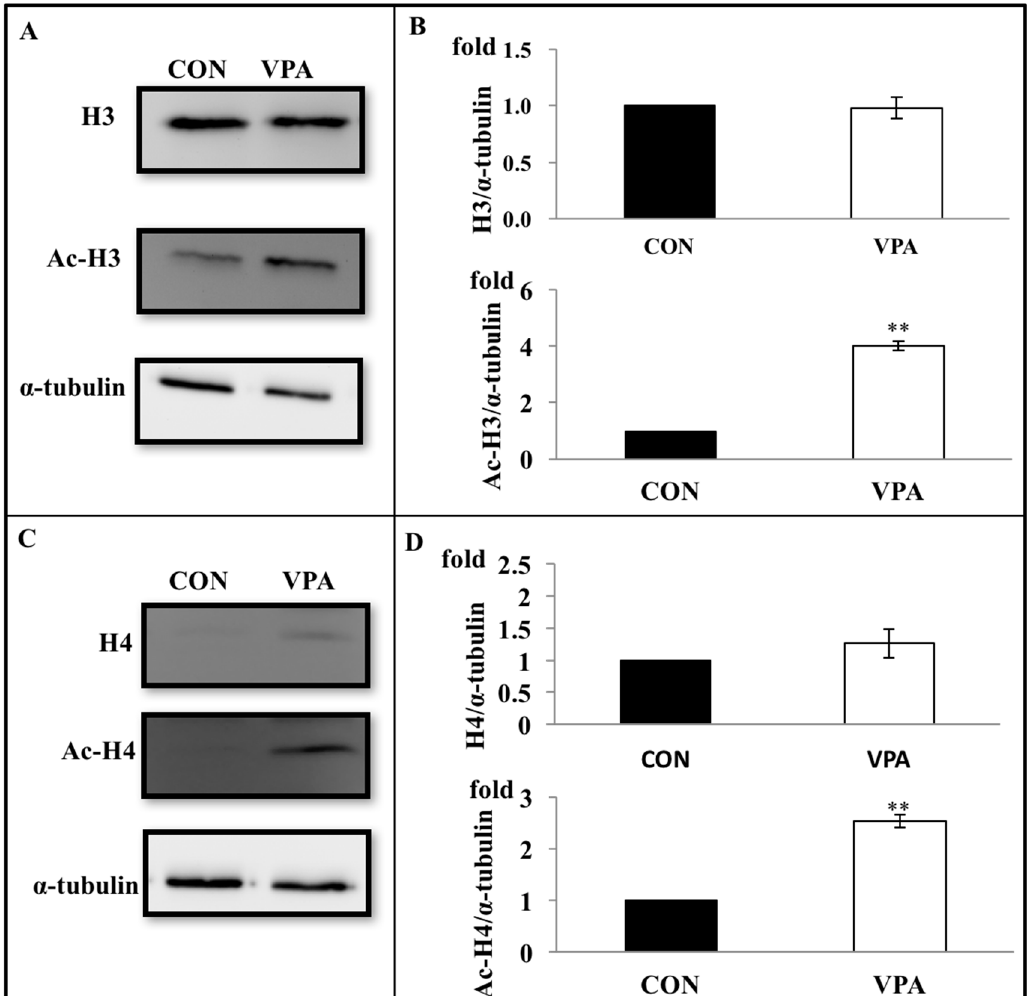
Figure 7. Effects of VPA on histone acetylation. Rat chondrocytes were cultured with daily VPA treatment for 4 days. Protein lysates were isolated and immunoblotted for histone 3 (H3), acetylated